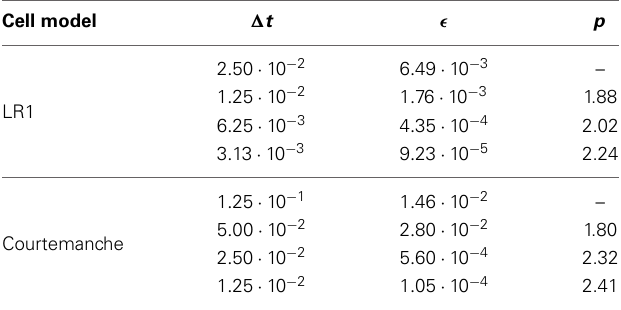
Table 2 | Convergence results for the SDIRK2 method applied as the PDE solver for the bidomain model.